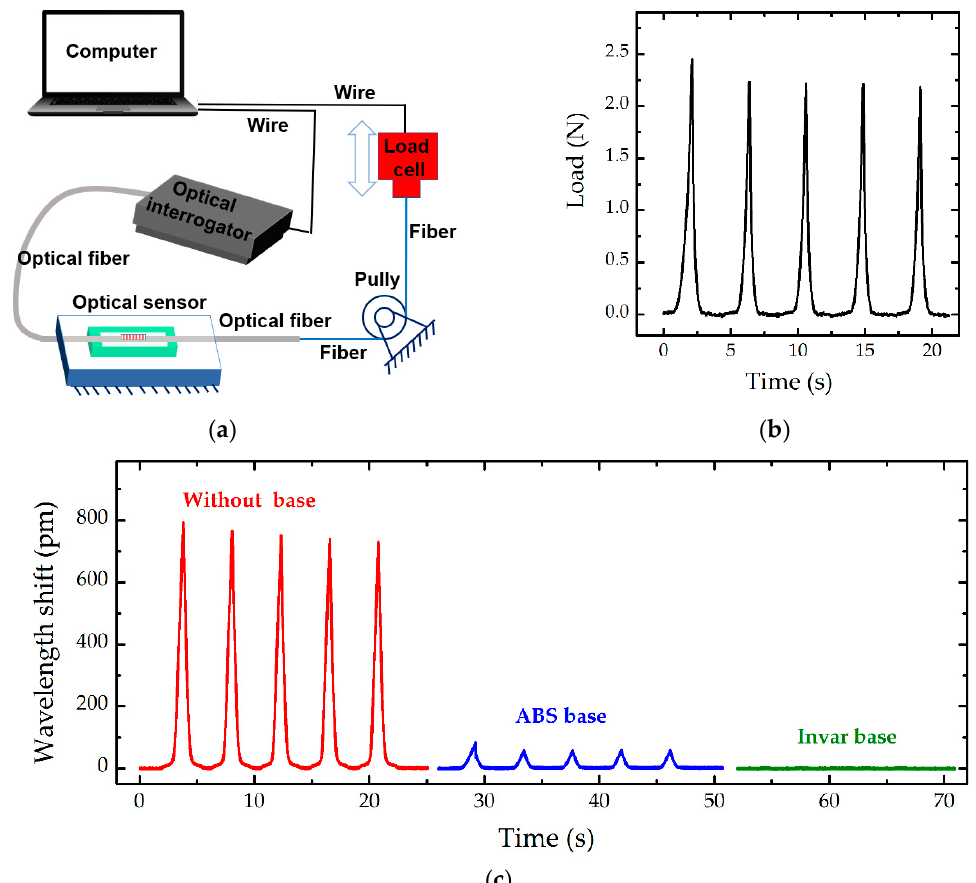
Figure 5. ( a ) Schematic of the designed loading system, aiming to analyze the influence of stress transmitted along the optical fibre on the output performance; ( b ) Illustration of the applied force at the end of optical fibre; and ( c ) Comparison among the measured results of three samples: one without any base (in red), the other two with a base made of ABS (in blue) and Invar (in green), respectively, at the room environment of 22.0 ± 1 °C and 65 ± 5% RH.